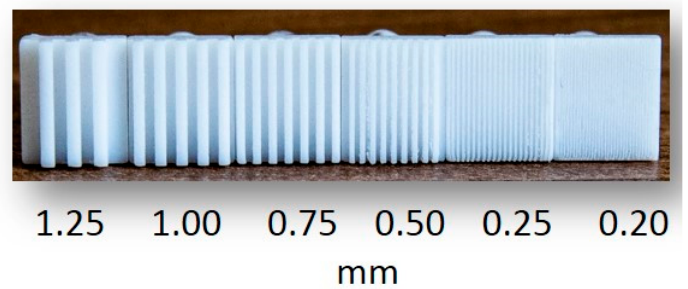
Figure 1. Gratings with decreasing sized grooves / bars (0.20 mm on the right). With children, only three gratings were used (0.75 mm, 1.00 mm and 1.25 mm), while, for adults, the complete set was used.